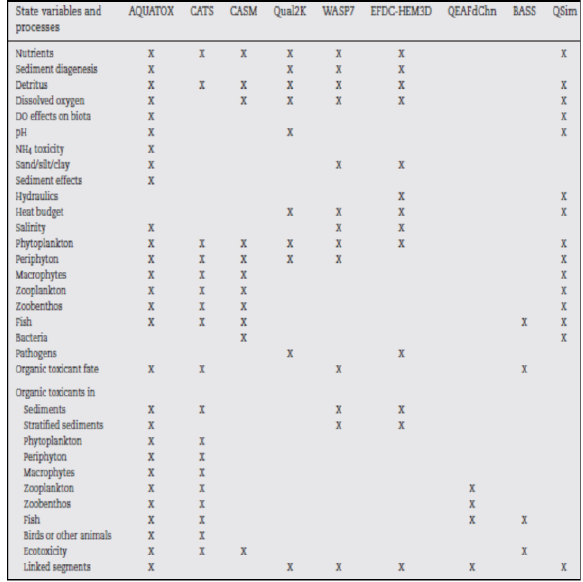
Table 1. The comparison of AQUATOX and